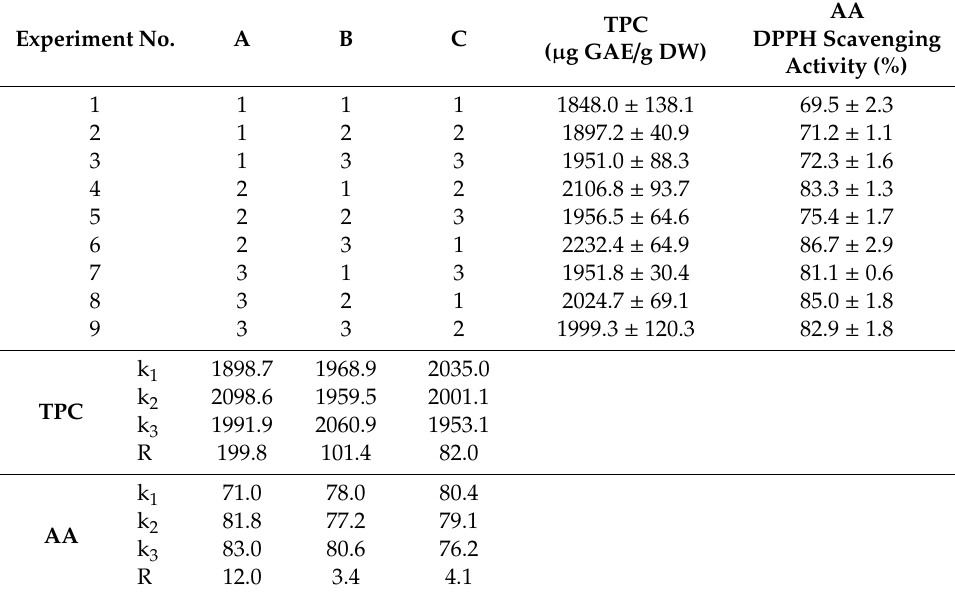
Table 3. L 9 (3 4 ) Orthogonal experiment for extrusion of